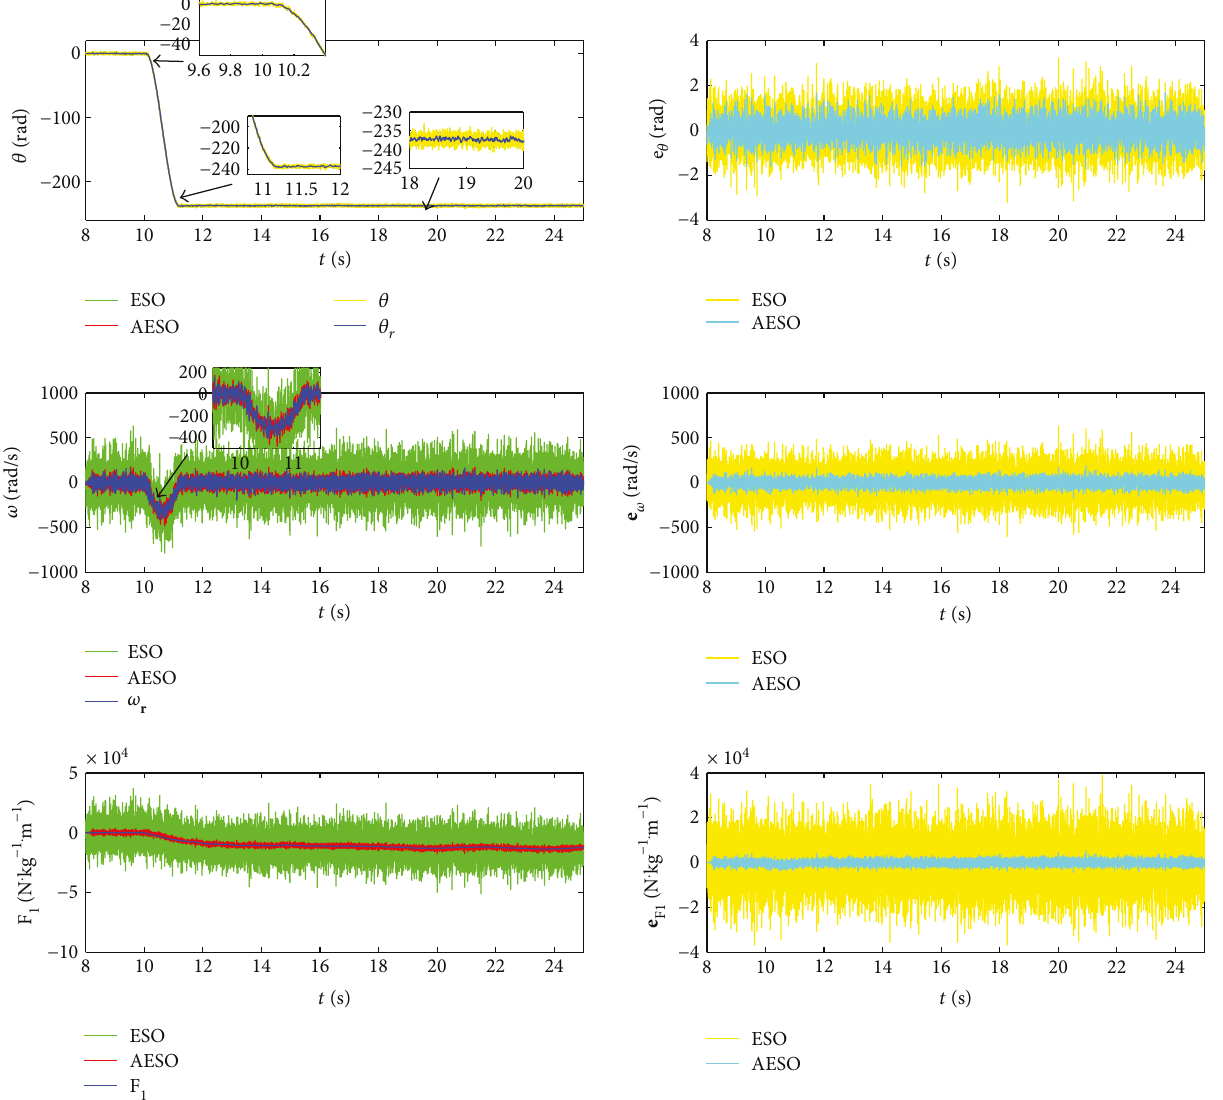
Figure 8: Estimation comparisons of ESO and AESO by the proposed NFTSM